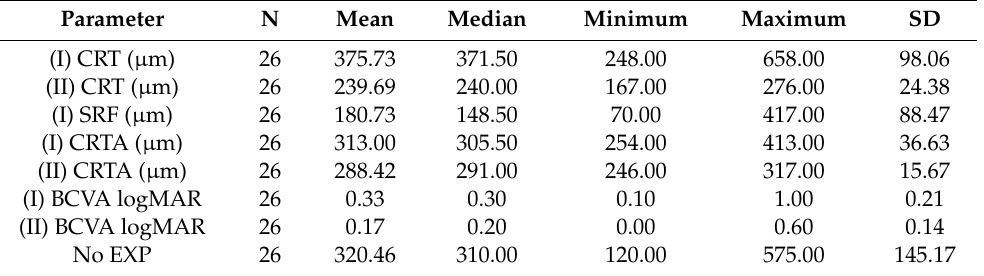
Table 5. Baseline characteristics and results of SMPLT in the subgroup of patients with a total resolution of subretinal fluid (SRF).